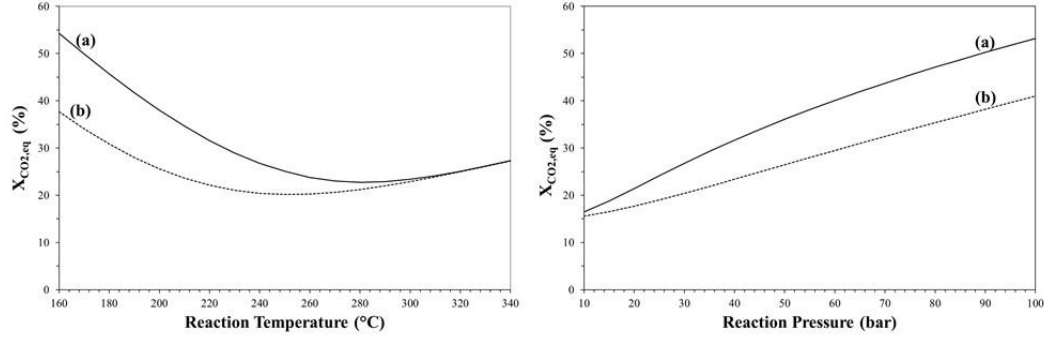
Figure 7. CO 2 equilibrium conversion of CO 2 -to-DME ( a ) and CO 2 -to-MeOH ( b ) process as a function of reaction temperature ( left ) and pressure ( right ).